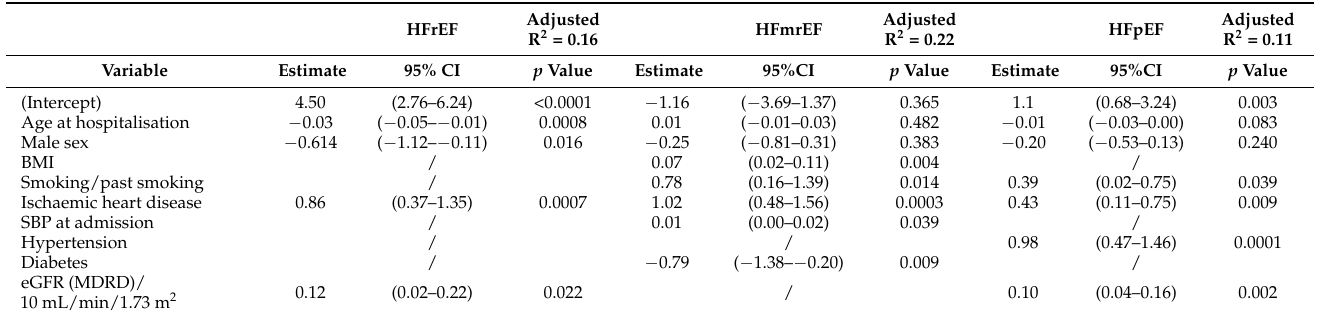
Table 5. Predictors of HF drug prescription and higher prescription score in HFrEF, HFmrEF, and HFpEF using the linear regression